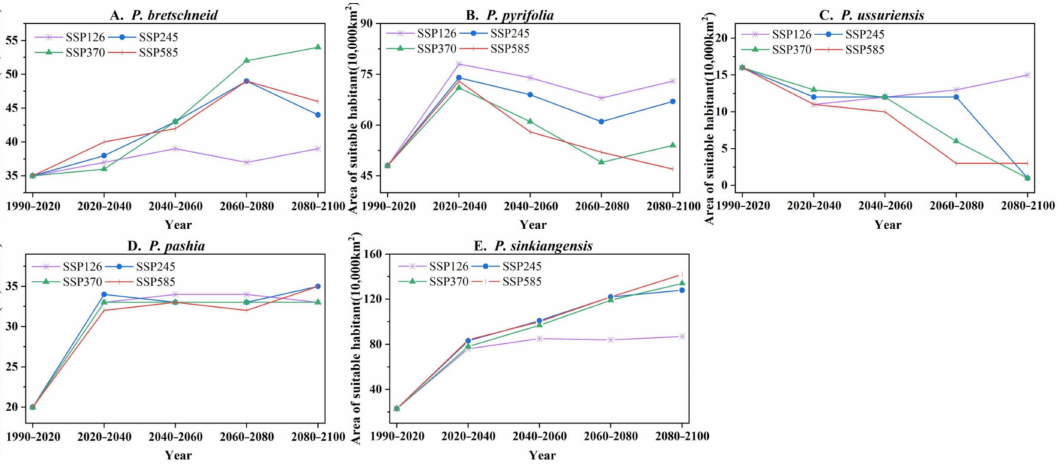
Figure 6. Change map of potential planting areas (habitat suitability > 0.5) for different species of ( A ) P.bretschneld , ( B ) P. pyrifolia , ( C ) P.ussuriensis , ( D ) P.pashia , ( E ) P.sinkiangensis . (i.e., SSP1-2.6, SSP2-4.5, SSP3-7.0 and SSP5-8.5 have been modeled from 2020 to 2100,